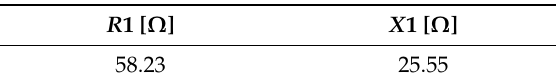
Figure 12. Initial Zone 1 settings and measured loops for double-phase-to-ground faults grouped in ( a ) set D 1 for Zone 1 calculation, and ( b ) set F 1 for zone 1 calculation. Table 2. Initial zone 1 reach